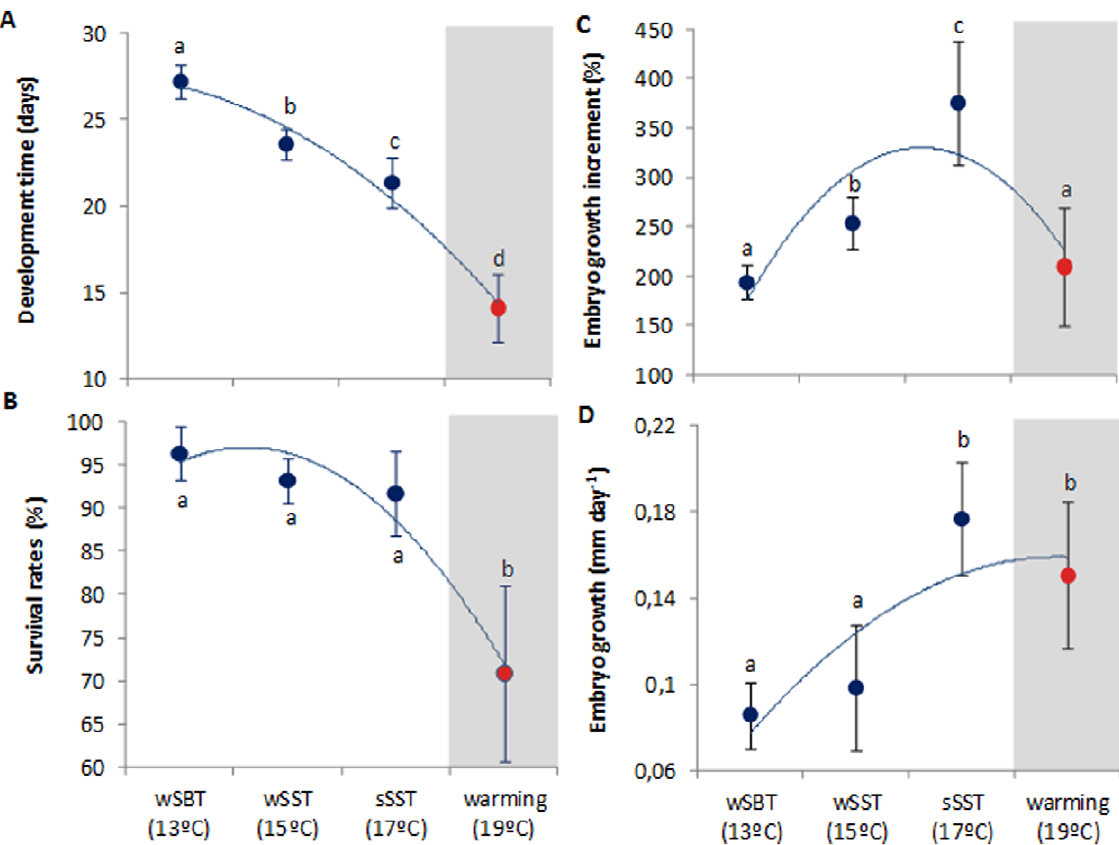
Figure 1. Effect of warming in the early ontogeny squid, Loligo vulgaris, namely: Development time (A), survival rates (B) and growth rates (% - C; mm day 2 1 - D) of embryos at the different temperature scenarios (red symbols highlight the future summer scenario). Values are mean 6 SD. Blue lines represent trendlines and different letters represent significant differences (more statistical details in Supporting Tables).